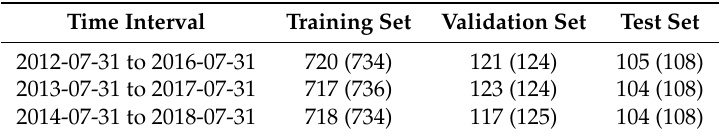
Table 2. Specification of the number of samples for each set.